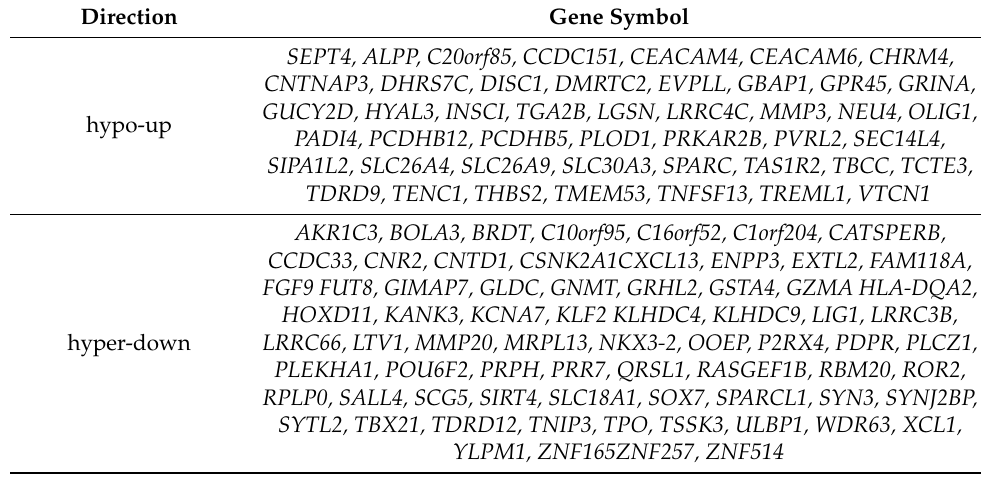
Table 1. Gene symbol of 46 hypo-up genes and 71 hyper-down